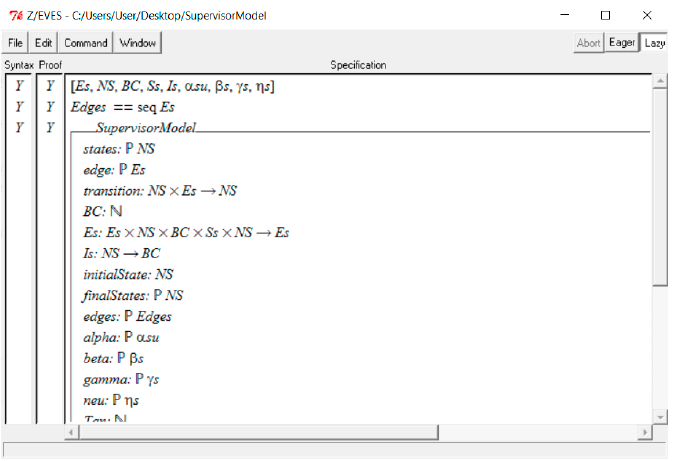
Figure A1. The snapshot of the formal specification analysis of supervisor model.